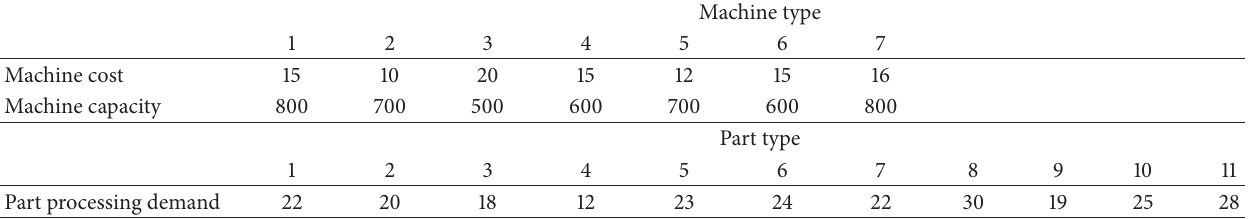
Table 3: Machine cost, machine capacity, and part processing demand for Example 1.